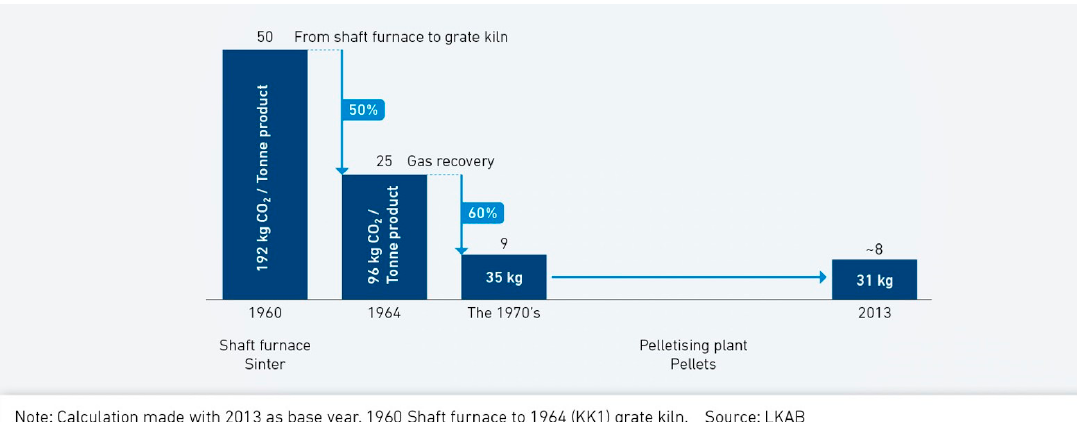
Figure 4. Agglomeration of iron ore development in fuel consumption (oil equivalents per ton of product) and CO 2 emissions since 1960.